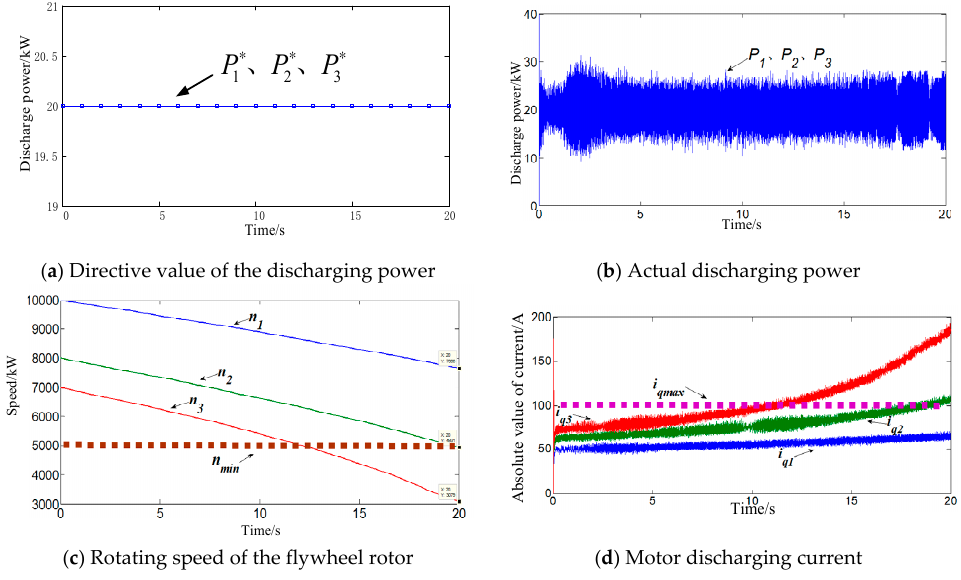
Figure 19. Simulation waveforms of discharging power distributed by equal distribution.